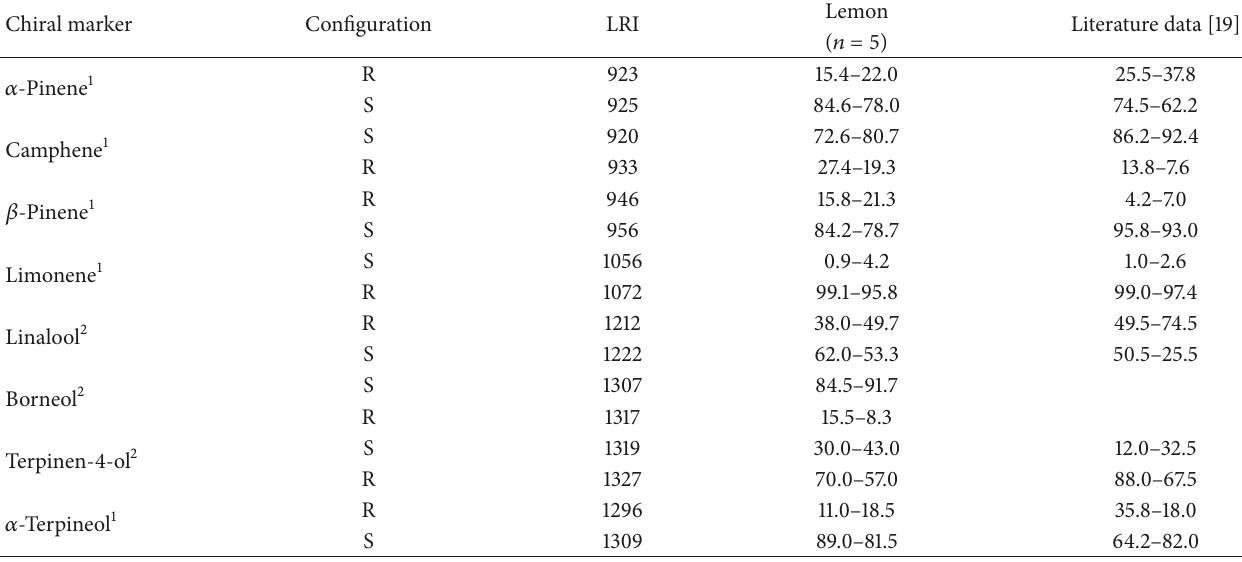
Table 4: Chiral markers, calculated LRI, and corresponding enantiomeric ratio for lemon fibre. Chiral marker